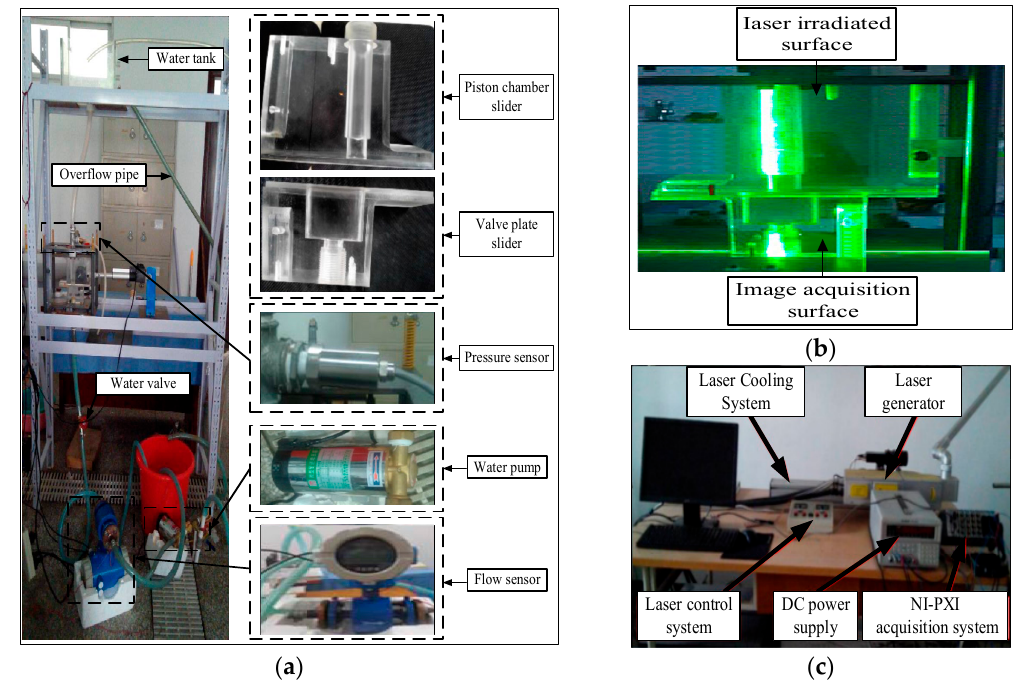
Figure 12. Experimental test rig. ( a ) Water supply system and piston-valve plate slider system; ( b ) PIV measuring areas; ( c ) PIV system and data acquisition system.